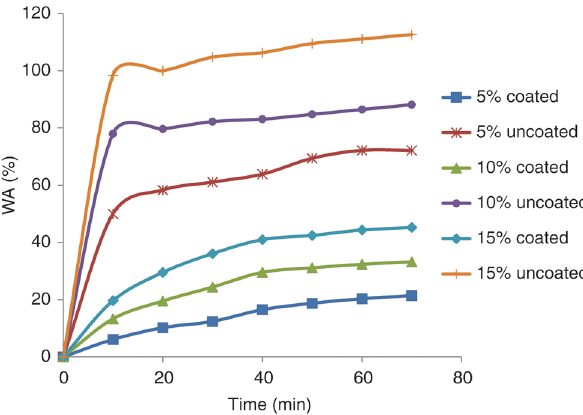
Figure 14: WA of all the samples (coated and uncoated).